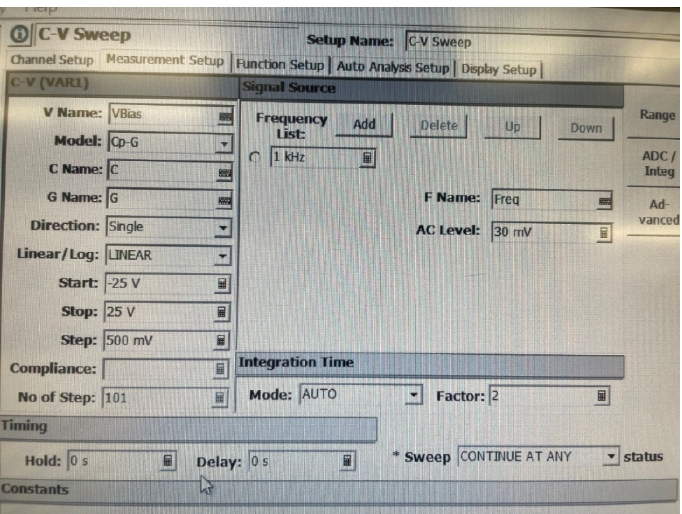
Figure 4. Measurement settings for the B1500A Semiconductor Device Analyzer.